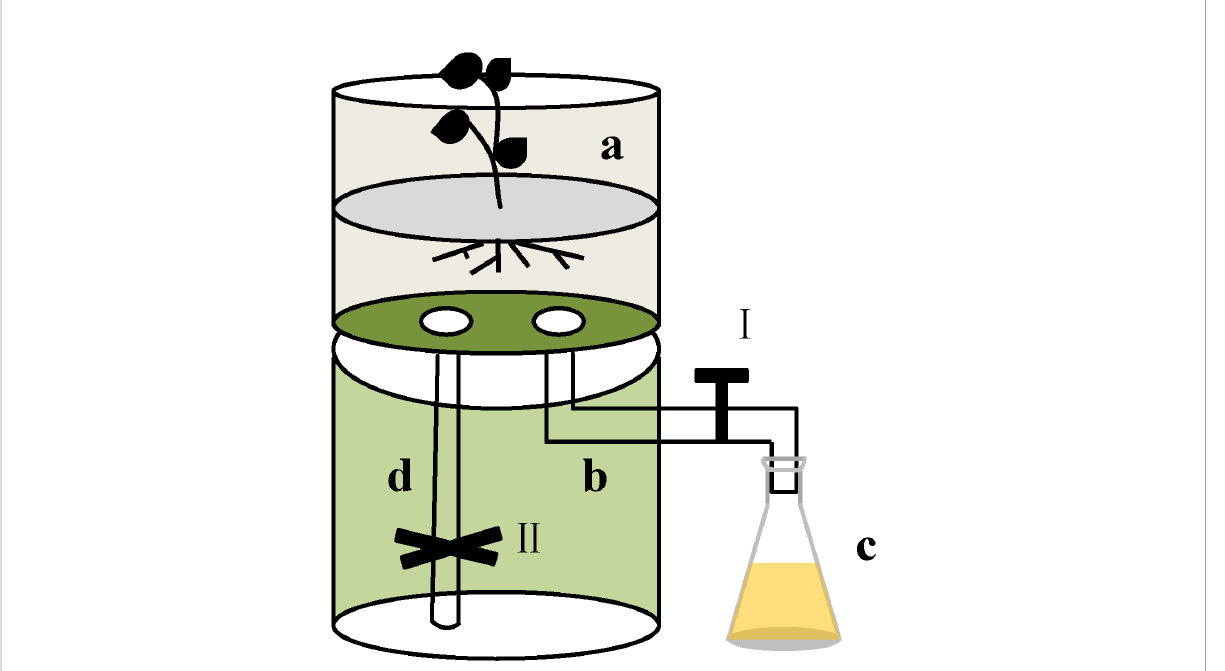
FIGURE 1 The device for collecting root exudates from F. bidentis. The device was made of PVC tube (160mm diameter and 40cm height) and was divided into two parts. The plant grew at the top of the device (A) . There is a hose (B) , which is connected to a triangular fl ask (C) , in the lower part. I was the control valve. During the growth, sterile water was poured in the top of the device (A) and the root exudates were collected in a triangular fl ask (C) . We can also collect the remaining root exudates through hose (D) , and the process was controlled by valve